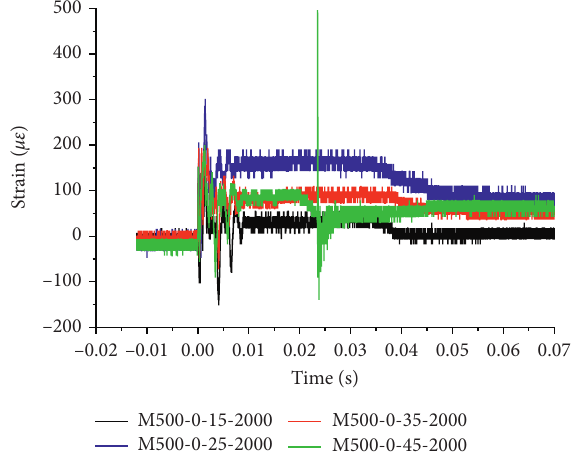
Figure 8: Time history-strain curve of the bolted rock under different